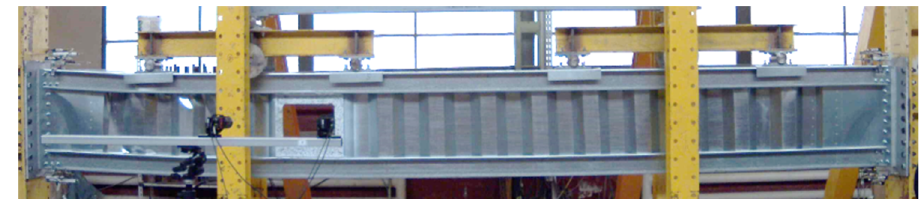
Figure 6. Deformed shape of the CWB-SW-WO assembled by spot welding.